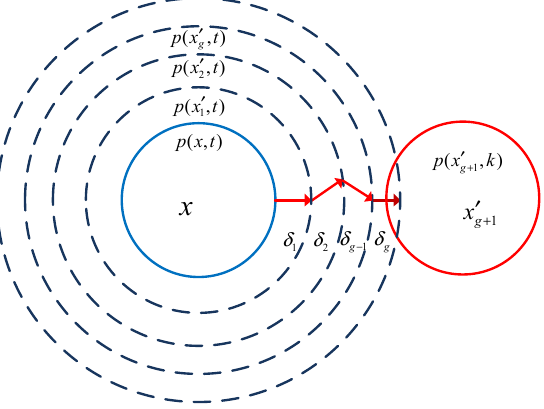
Figure 4. The exploration process of perturbed image. In the SAGM, we utilize adaptive DE to explore the perturbed vectors. The initial perturbed vector between − 1 and 1 is generated using uniformly distributed randomization, and its dimension is consistent with the dimension of the input image. Each element of the initial vector δ 0 is generated by Equation (15).